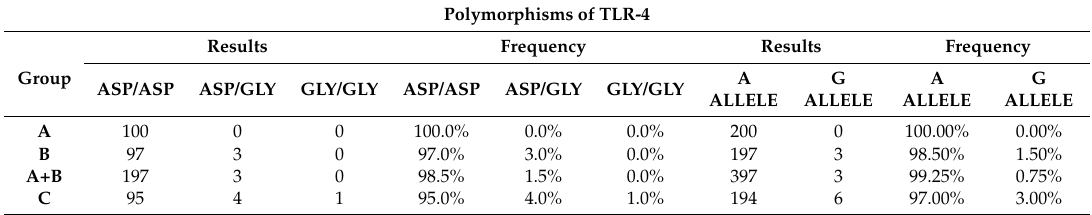
Table 2. Frequencies of Toll-Like-Receptor-4/Asp 299 Gly polymorphism.